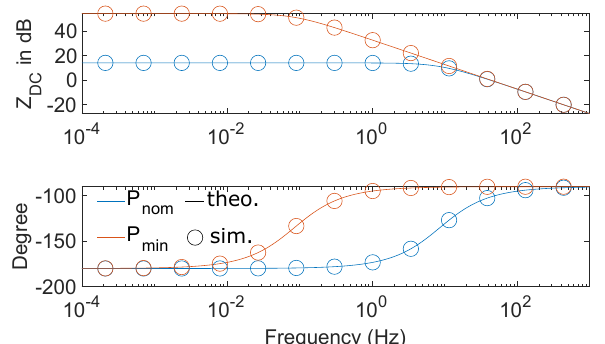
Figure 12. Wind Turbine Z DC Response at Nominal and Minimum Power.